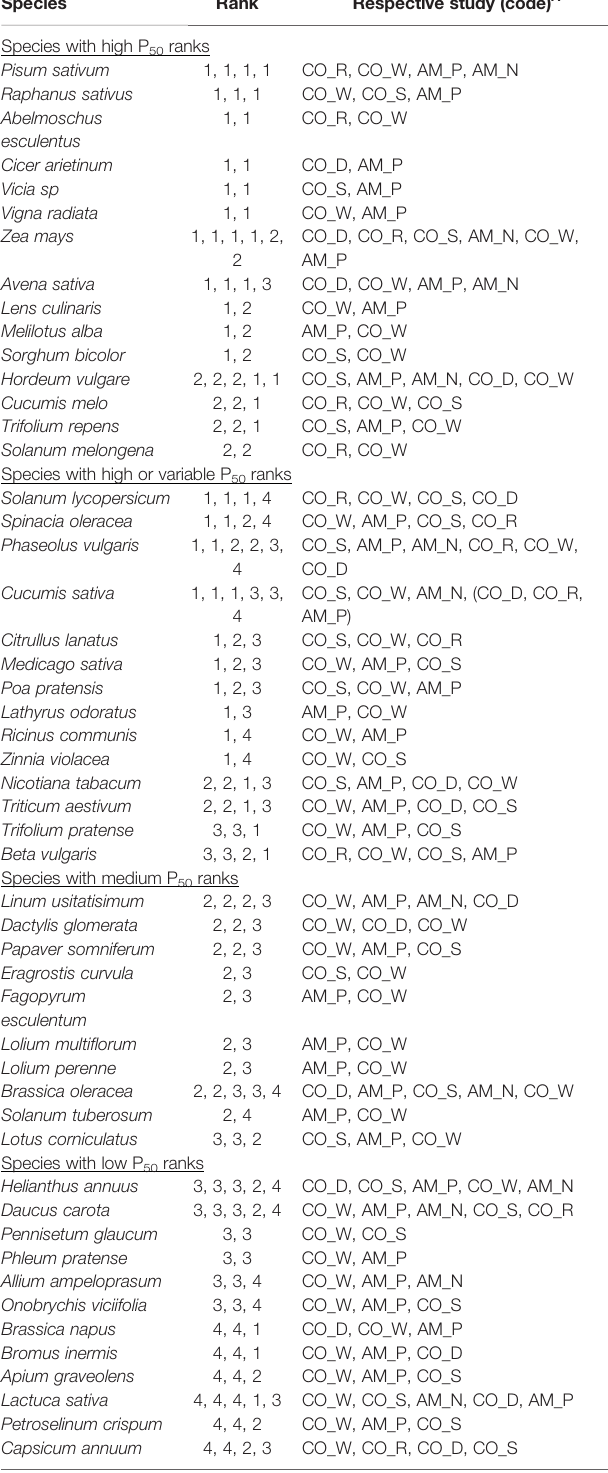
TABLE 2 | Species sorted by overall P 50 rank, from the highest (score 1 = most long-lived, with a P 50 above the 75 th percentile in a given study) to the lowest (score 4 = lowest P 50 , below the 25 th percentile), and where score 2 = between the 75 th and 50 th percentiles, score 3 = between the 50 th and 25 th